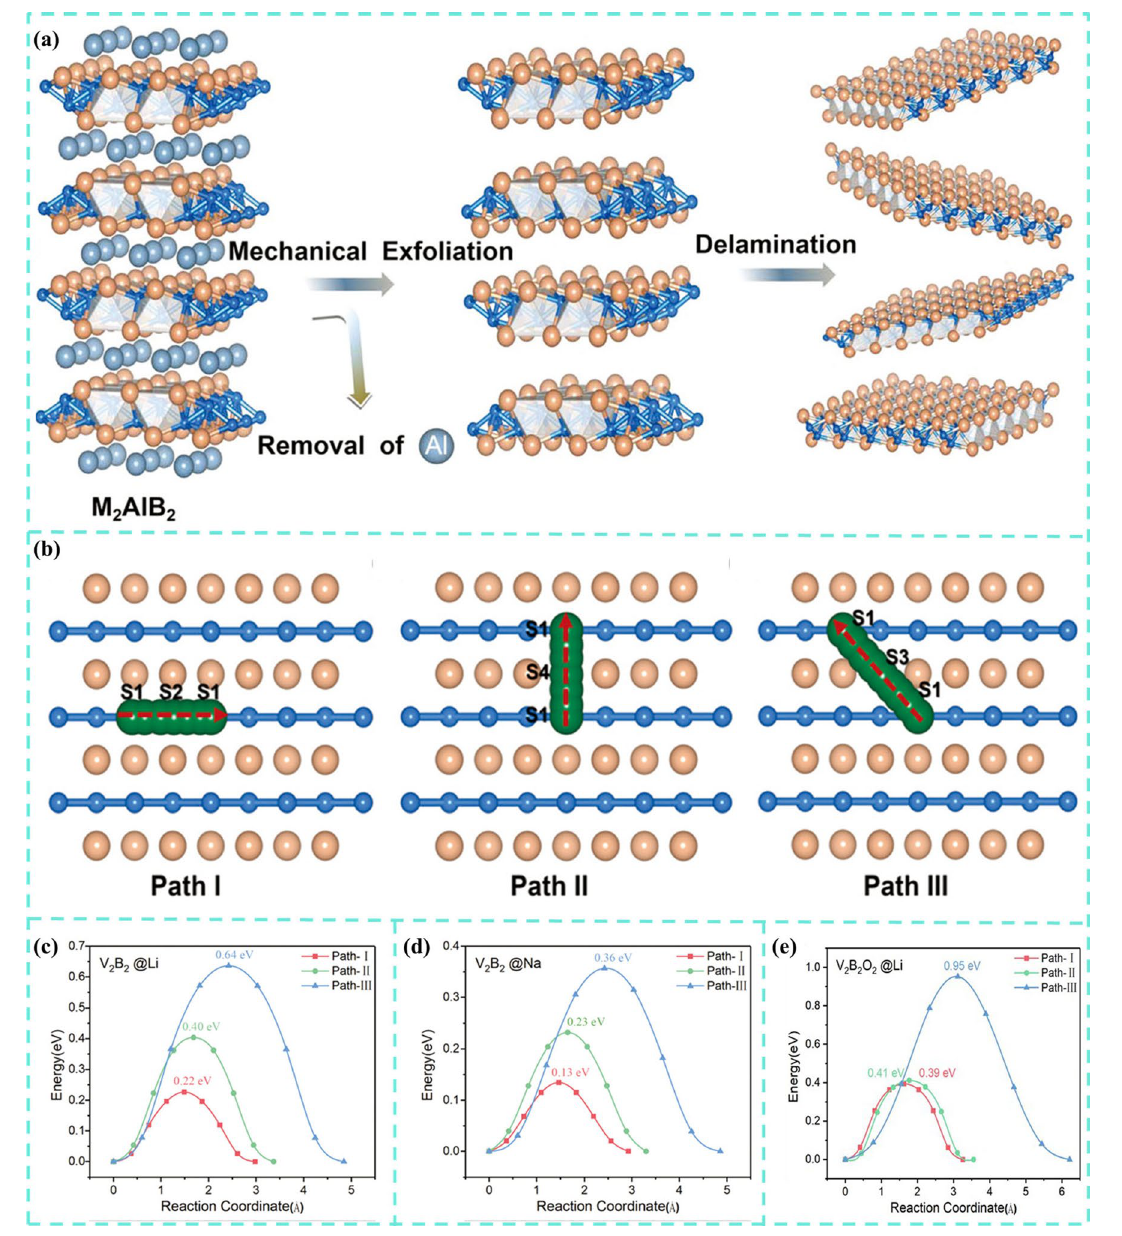
Fig. 20 a Schematic diagram of removing Al to form MBenes by mechanical exfoliation in the MAB phase. b Schematic diagram of the metal cation diffusion migration paths considered on monolayer MBenes: left: S1 → S2 → S1, middle: S1 → S4 → S1 and right: S1 → S3 → S1. c Diffu- sion energy curves of Li ions on V 2 B 2 . d Diffusion energy curves of Na atoms on V 2 B 2 . e Diffusion energy curves of Li ions on V 2 B 2 O 2 . Repro- duced with permission from Ref.